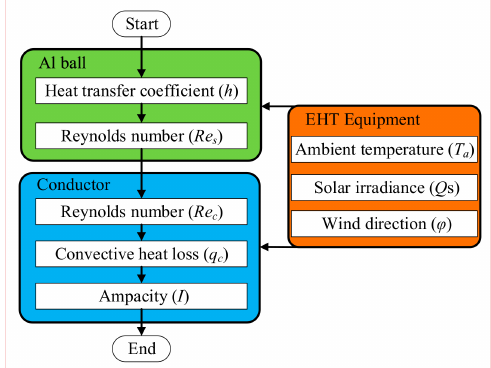
Figure 7. Calculation flowchart of conductor ampacity in EHT